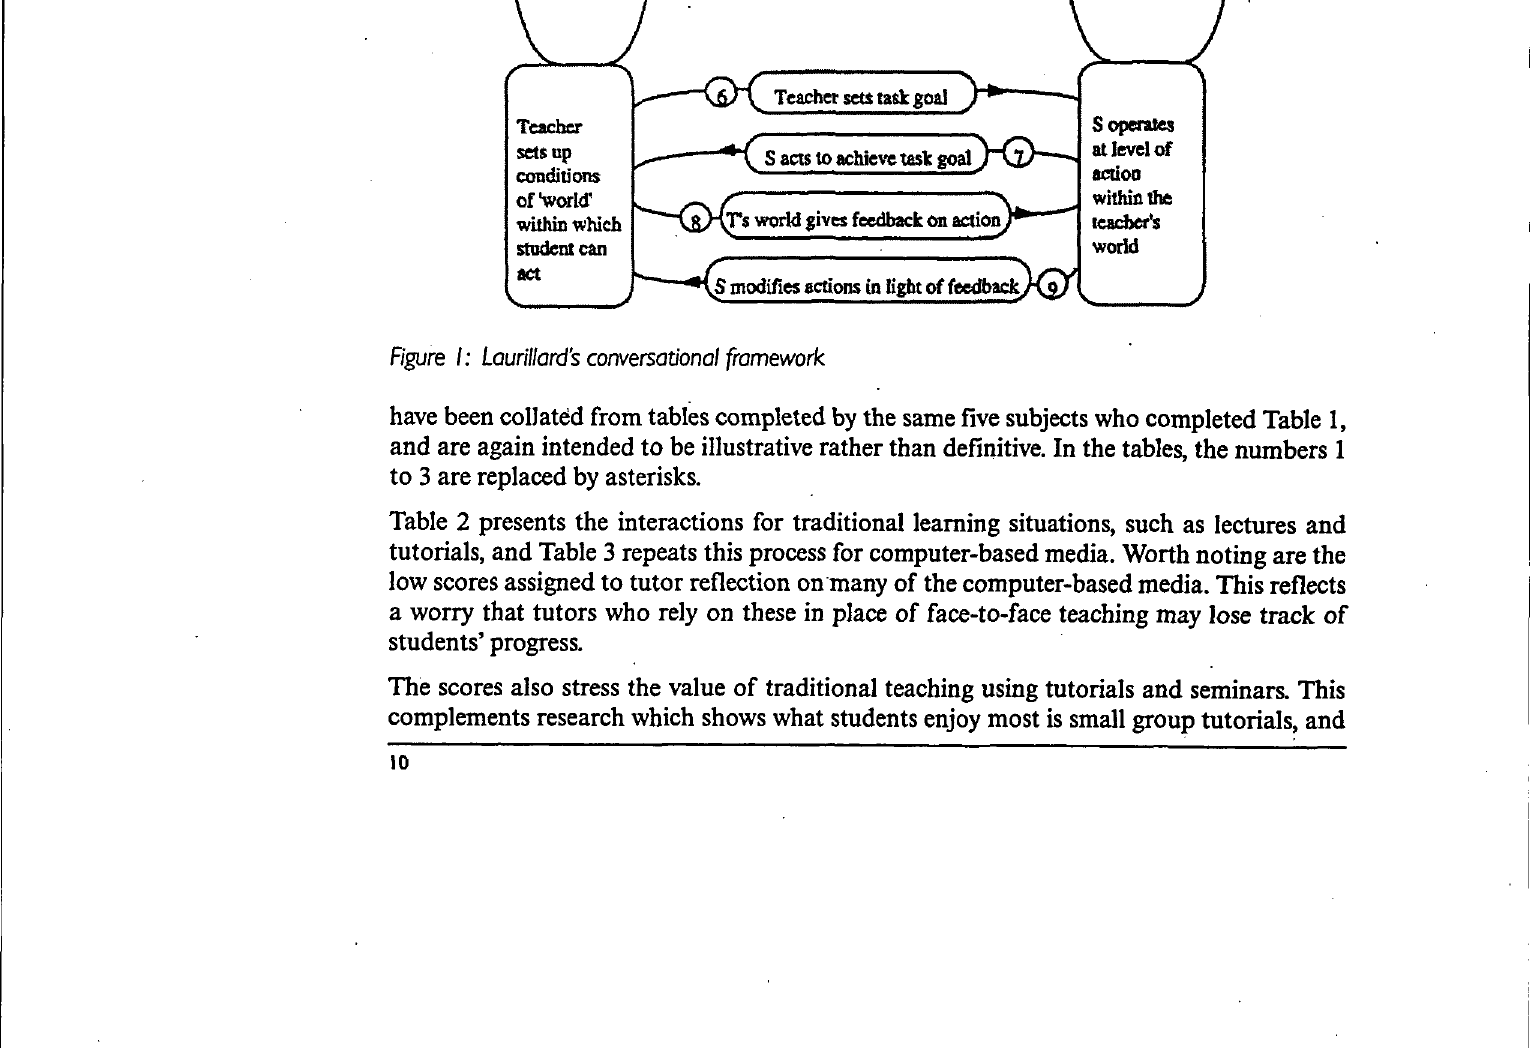
Figure I: Laurillard's conversational